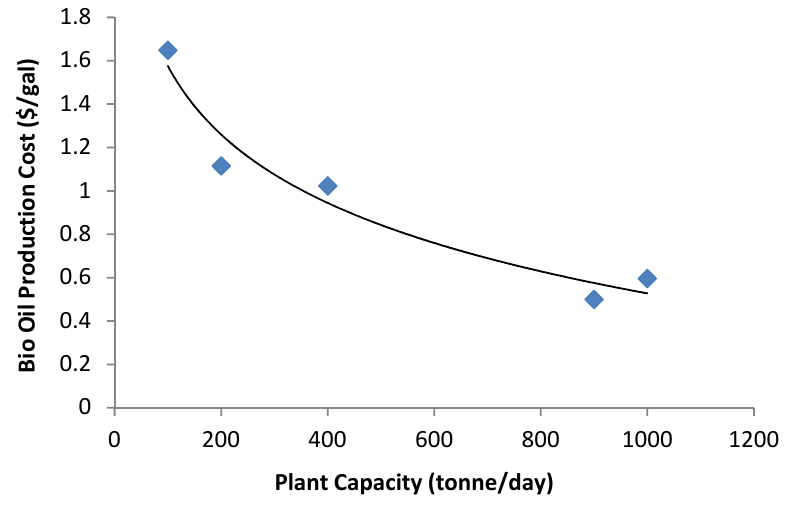
Figure 11. Bio-oil production cost with plant sizes for wet wood